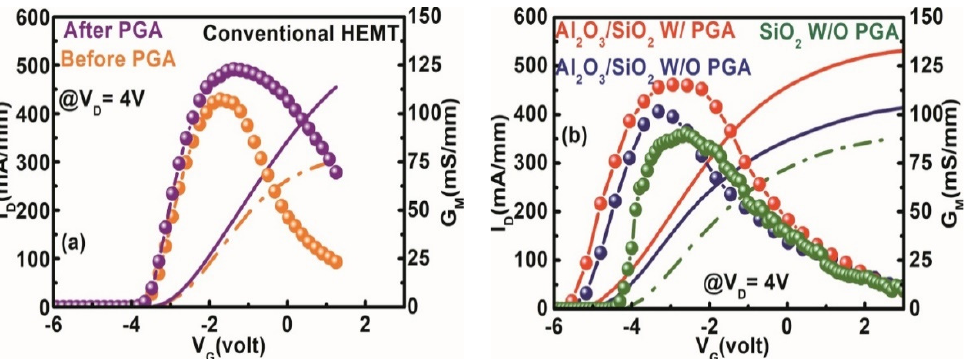
Figure 5. I D –V G characteristics of ( a ) conventional HEMT with and without gate annealing and ( b ) Al 2 O 3 /SiO 2 MOS–HEMT with and without gate annealing treatment, and SiO 2 MOS–HEMT without PGA treatment.